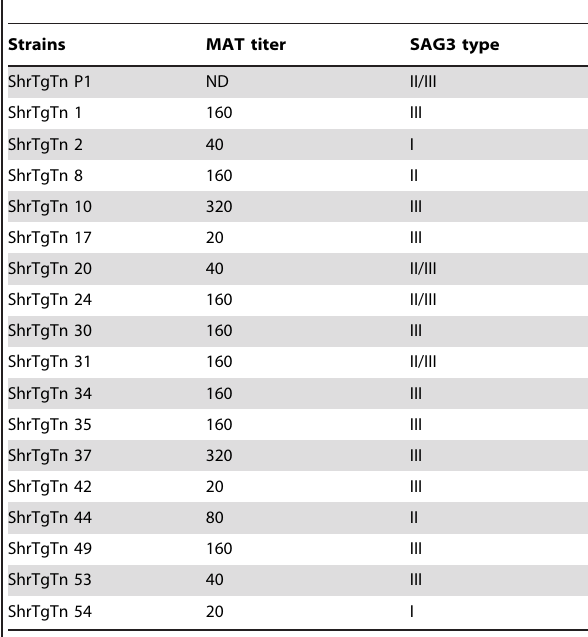
Table 2. Data about positive sheep heart